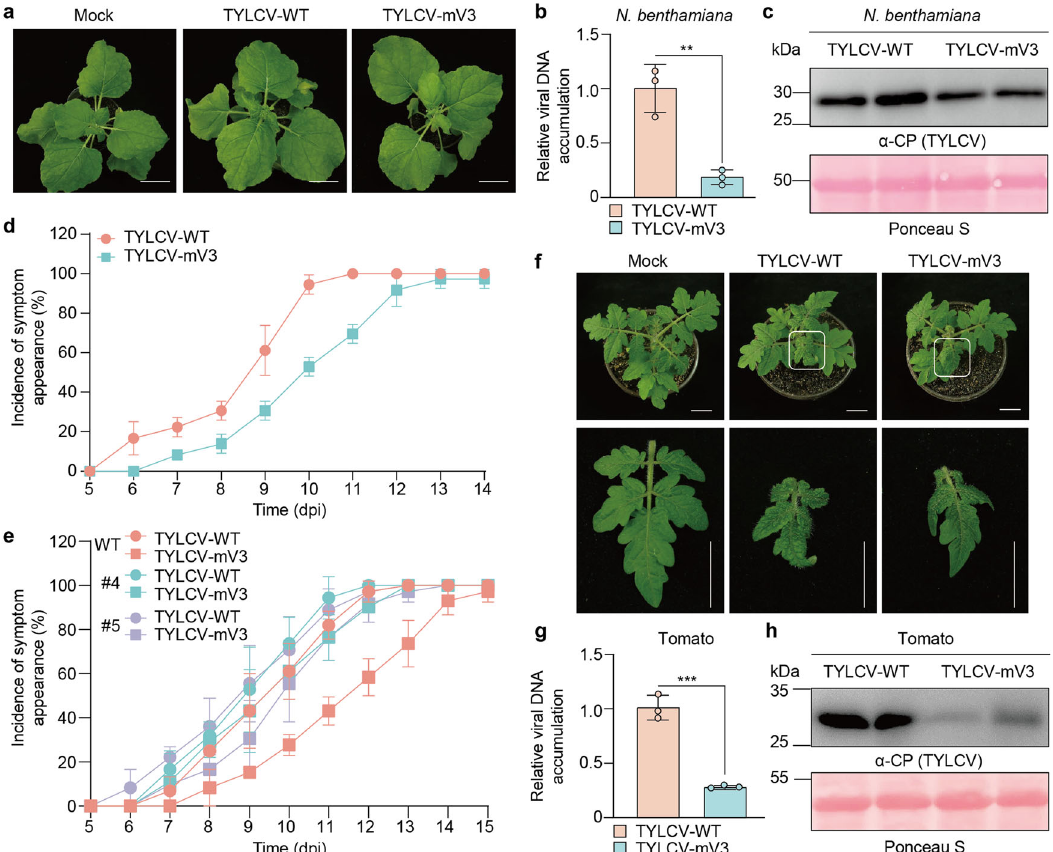
Fig. 4 V3 is required for full TYLCV infection in N. benthamiana and tomato. a Symptoms of N. benthamiana plants inoculated with wild-type TYLCV (TYLCV-WT), a V3 null mutant TYLCV (TYLCV-mV3), or mock-inoculated (pCAMBIA2300 empty vector), at 10 dpi. Bar = 2 cm. b Viral DNA accumulation in TYLCV-WT- and TYLCV-mV3-infected plants in ( a ), measured by qPCR. Data are the mean of three independent biological replicates. Error bars represent SD. An asterisk indicates a statistically signi fi cant difference according to unpaired Student ’ s t test (two-tailed), *** p < 0.01. 25S RNA was used as internal reference. c Western blot showing TYLCV CP accumulation in systemic leaves of TYLCV-WT- and TYLCV-mV3-infected plants from ( a ). Ponceau S staining of the large RuBisCO subunit serves as loading control. This experiment was repeated three times with similar results; representative images are shown. d , e Incidence of symptom appearance in WT ( d , e ) or V3 transgenic ( e ) N. benthamiana plants infected with TYLCV-WT or TYLCV-mV3. Data are the mean of three independent biological experiments. Error bars represent SD. At least 8 plants were used per viral genotype and experiment. For images of symptoms in the V3 transgenic lines, see Supplementary Fig. 10d. f Symptoms of tomato plants inoculated with WT TYLCV (TYLCV-WT), a V3 null mutant TYLCV (TYLCV-mV3), or mock-inoculated (pCAMBIA2300 empty vector), at 10 dpi. Bar = 2 cm. g Viral DNA accumulation in TYLCV-WT- and TYLCV-mV3-infected plants from ( f ), measured by qPCR. Data are the mean of three independent biological replicates. Error bars represent SD. An asterisk indicates a statistically signi fi cant difference according to unpaired Student ’ s t test (two-tailed), *** p < 0.001. 25S RNA was used as internal reference. h Western blot showing TYLCV CP accumulation in systemic leaves of TYLCV-WT- and TYLCV-mV3-infected plants from ( f ). Ponceau S staining of the large RuBisCO subunit serves as loading control. This experiment was repeated three times with similar results; representative images are shown. The TYLCV isolate used in these experiments is TYLCV-BJ. The original data from all experiments and replicates can be found in the Source data fi re fl ect the transition of the protein from the ER to the Golgi apparatus.